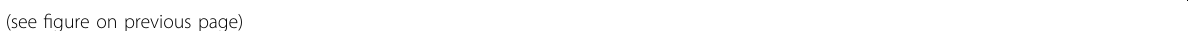
Fig. 2 Human scalp HFSCs display different molecular features from their Murine counterparts. a UMAP plots showing the subpopulations of Hair follicle stem cells (SC1 + SC2). b Dot plot showing the expression of human HFSC signature genes. c Representative marker genes expression visualized on UMAP. IBLMkr, ORSMkr, and PRMkr: marker gene of IBL, mORS, and PR group respectively. Bulge & migraBulge: previously reported mHFSC subgroups signature genes for core bulge and migrating bulge respectively. See also Supplementary Tables S4. d Heatmap showing GSEA analysis results of previously characterized mHFSC subgroups markers (vertical axis) in the HFSCs subpopulations (horizon axis). Red indicates enrichment while blue indicate depletion. NES: normalized enrichment score. * P < 0.05. e Heatmap showing the GSEA analysis results of MSigDB hallmark terms in the HFSC subpopulations. * P < 0.01. f Representative ( n = 5 HFs for the upper panel and n = 8 HFs from 3 individuals for the lower panel) IF images of hsHF sections and magni fi ed views of squared areas. Scale bars: 200 μ m. g Representative IF images ( n = 5 HFs from 3 individuals) of hsHF sections and magni fi ed views. Scale bars: 200 μ m. h Representative ( n = 3) IF images WT mouse telogen (P50)/anagen (2 weeks post depilation at P50) HF sections. Scale bars: 50 μ